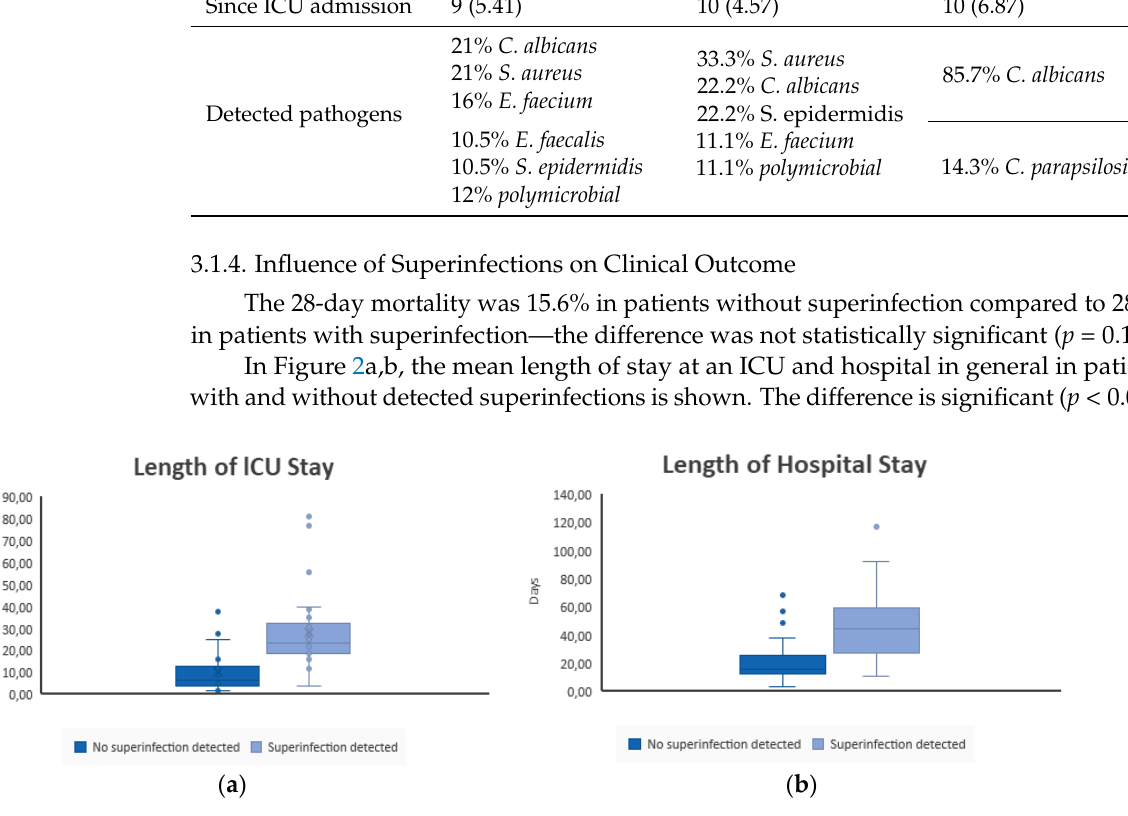
Figure 2. ( a ) Length of ICU stay (in days) of patients with no detected superinfection and with detected superinfection. ( b ) Length of hospital stay in general (in days) of patients with no detected superinfection and with detected superinfection.